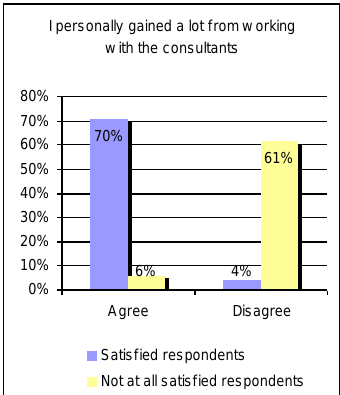
Figure 6: The Importance of Being